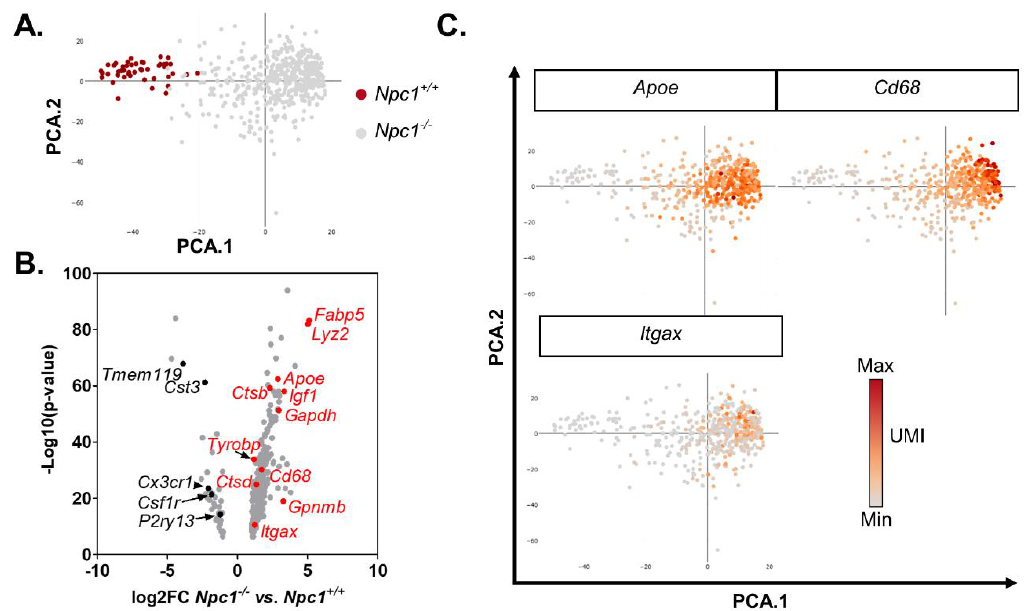
Figure 2. Differentially expressed genes in microglia. ( A ) Principal component analysis (PCA) of gene expression in microglia from seven-week-old Npc1 +/+ (red) and Npc1 −/− (gray) cerebellar tissue. ( B ) Volcano plot of differential gene expression between control and Npc1 mutant mice. ( C ) PCA plots showing expression level of microglial activation markers ( Apoe , Cd68 , and Igax ). Increasing red intensity corresponds to increasing unique molecular identifier (UMI)